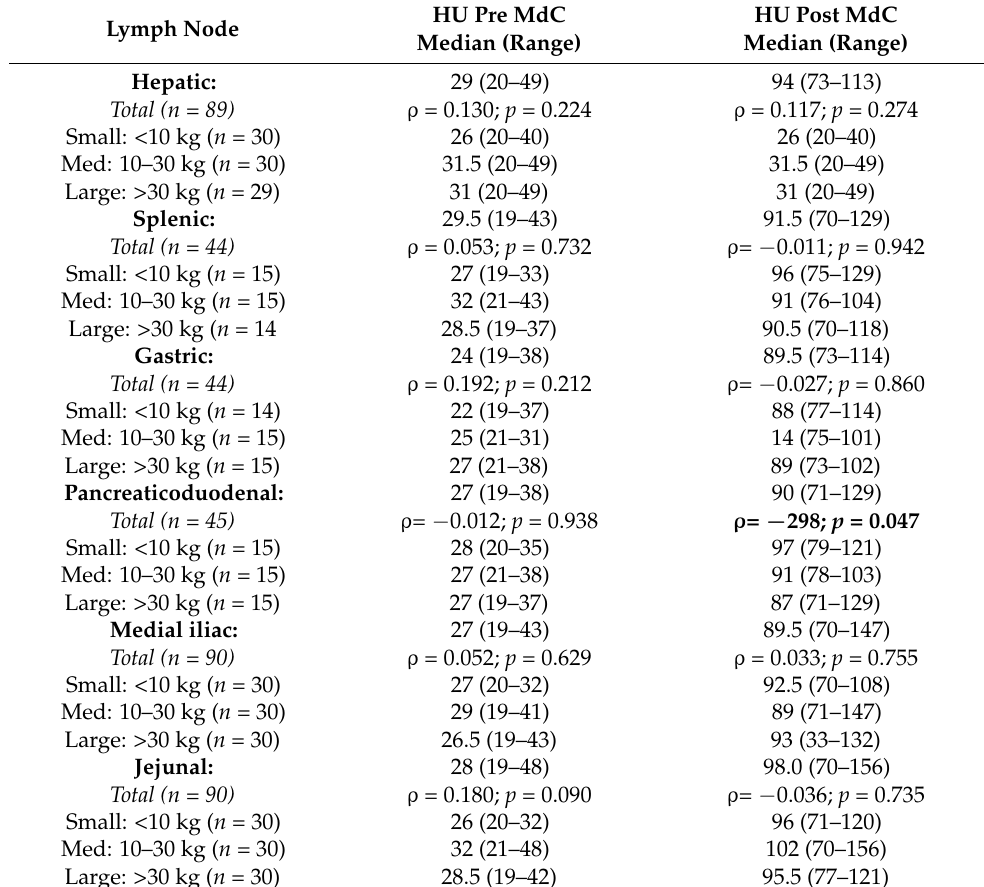
Table 3. Median and range (within parentheses) values of X-ray attenuation of ALs before and after contrast administration according to body weight categories. Data are stratified by